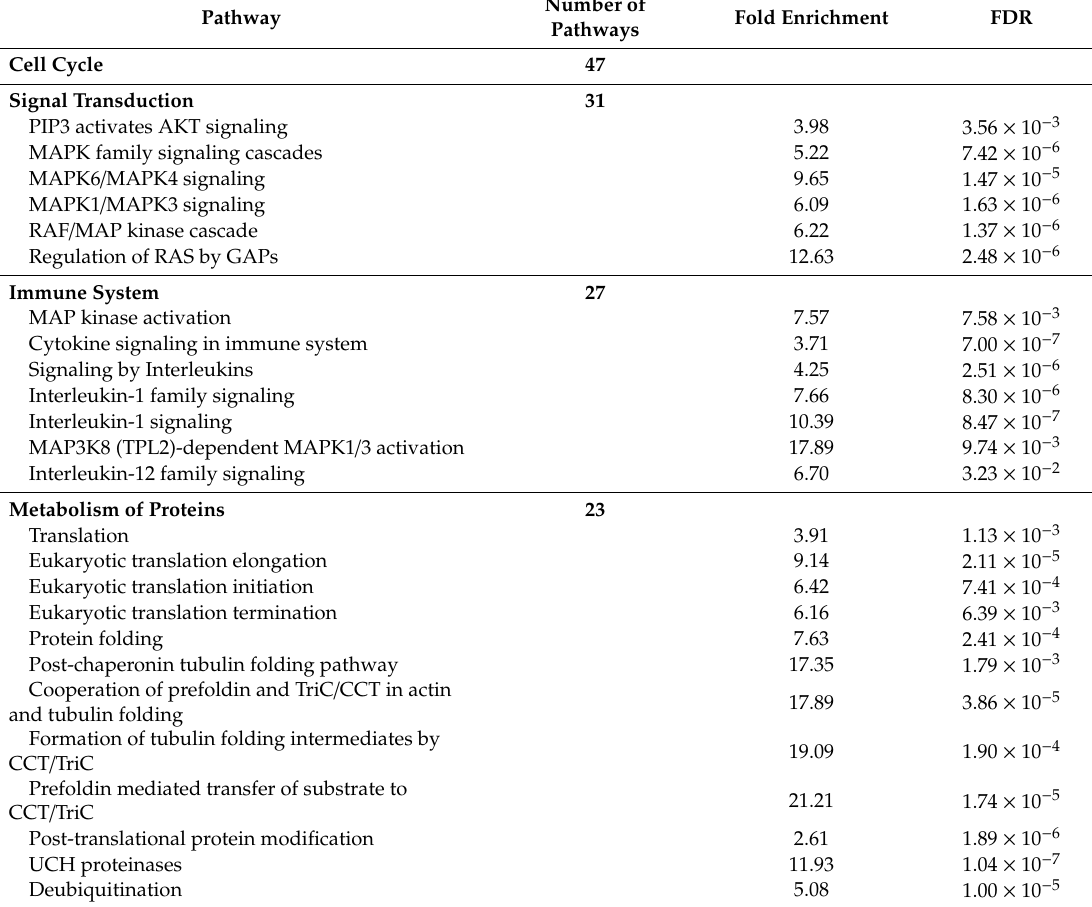
Table 4. Overrepresented pathways in the collagen (COL) group after 12 weeks of resistance training and supplementation. Main categories are shown with the number of annotated pathways and downstream pathways with the calculated fold enrichment and false discovery rate